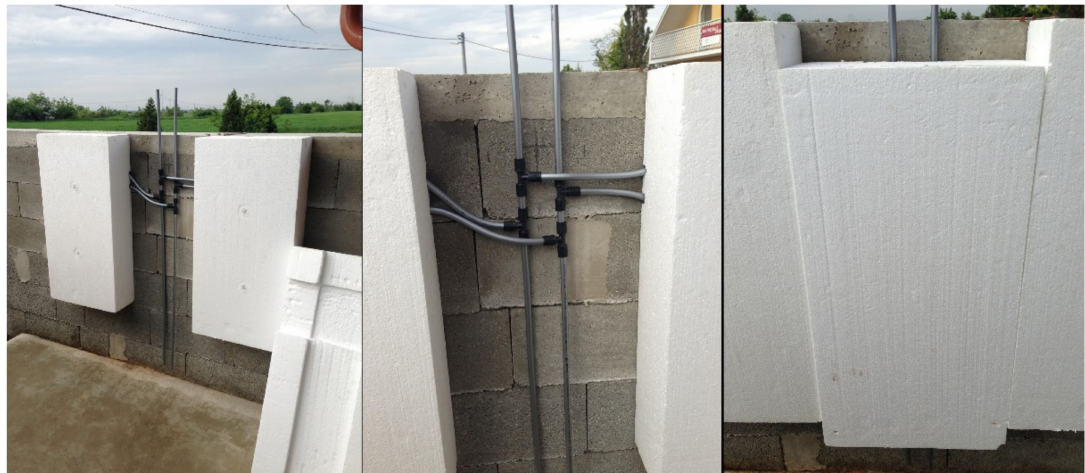
Figure 15. The principle of the contact thermal insulation system with ATP. [Author: Kal ú s].